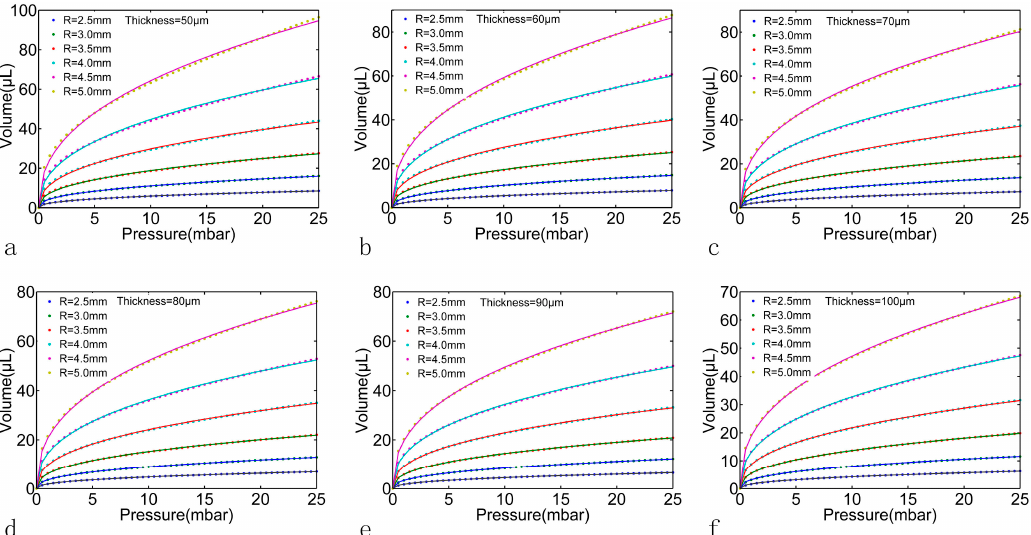
Figure 6. The pressure-volumes relationships of the PDMS membrane with different radius R and different thickness h derived from the FEM analysis. Subplot ( a – f ) represent the thickness of the PDMS membrane from 50 to 100 μ m with 10 μ m a step. Table 1. The value of the parameters m and N with different R and different thickness h .